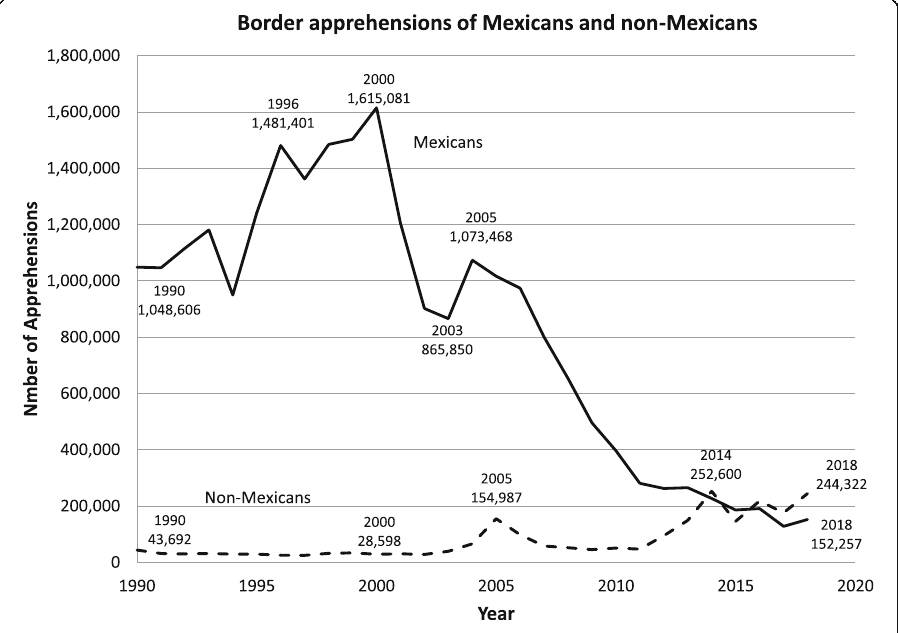
Fig. 12 Border apprehensions of Mexicans and